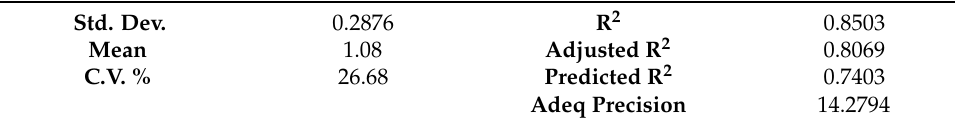
Figure 9. Contour plots of support parameters and Overhang Angle on Support Removal Effort.